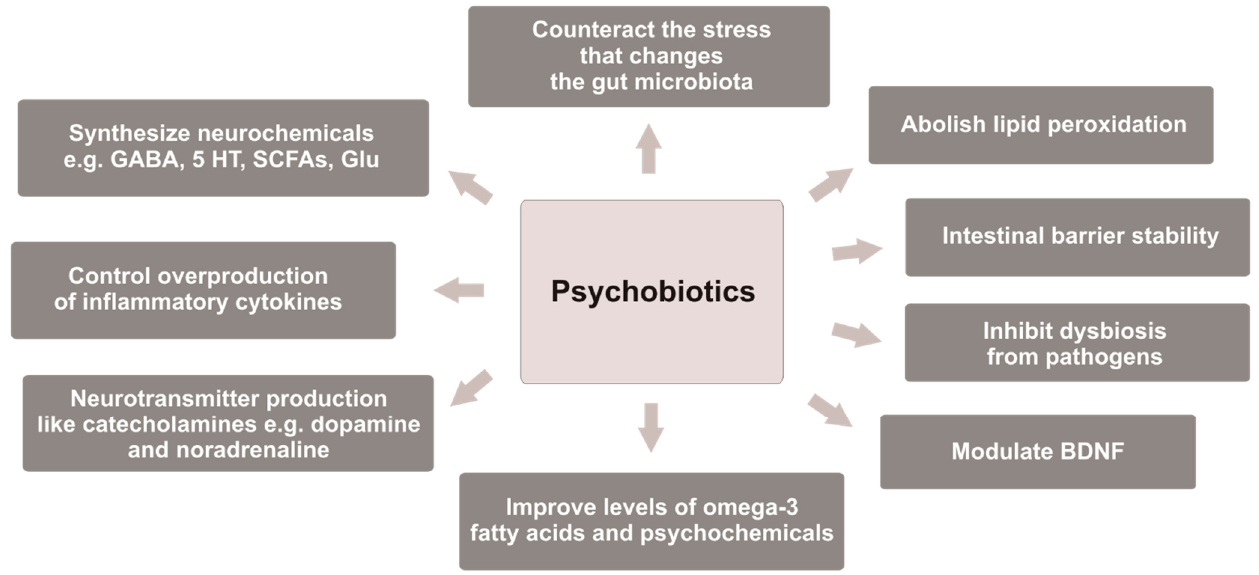
Figure 1. Properties of psychobiotics that may be responsible for alleviation of depression symptoms. GABA—gamma-aminobutyric acid; 5 HT—5-hydroxytryptamine; SCFAs—short-chain fatty acids; Glu—glutamate; BDNF—brain-derived neurotrophic factor.